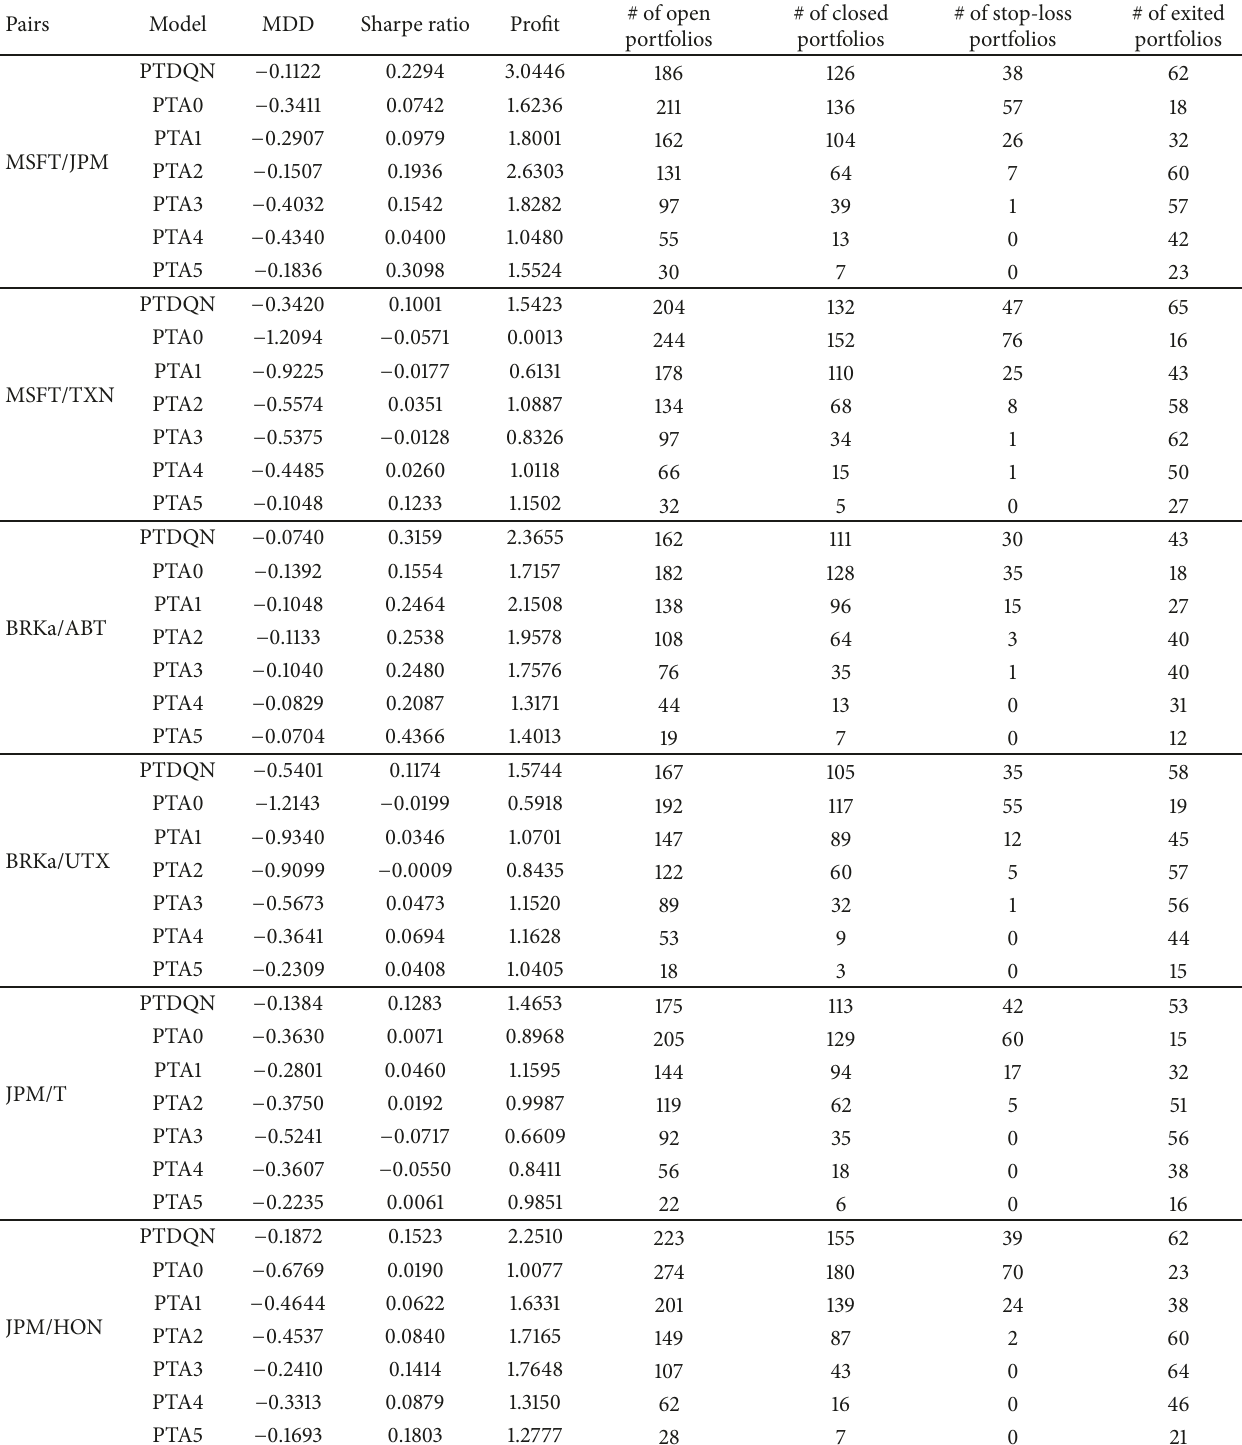
Table 8: Average top-5 performance results of the proposed method and the traditional pairs-trading strategy in the out-of-sample dataset using